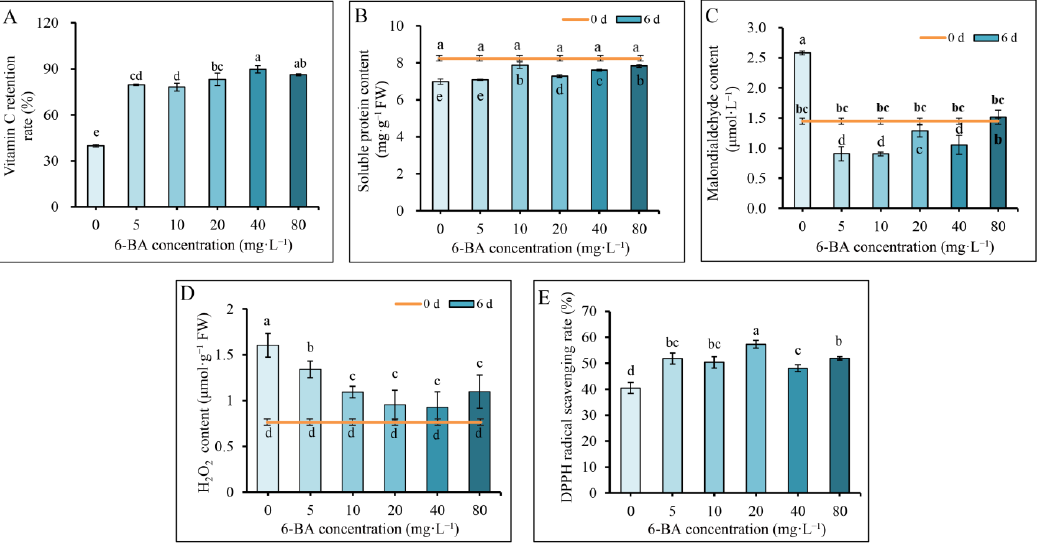
Figure 3. Postharvest 6-BA treatment maintains nutritional quality and antioxidant capacity of Chi- nese flowering cabbage during storage. Effect of postharvest 6-BA treatments on Vc retention rate ( A ), soluble protein content ( B ), malondialdehyde (MDA) content ( C ), H 2 O 2 content ( D ), and DPPH radical scavenging rate ( E ) of Chinese flowering cabbage. Each bar indicates the mean ± standard deviation of three biological replicates, and different lowercase letters indicate significant differ- ences between Chinese flowering cabbage under different treatments ( p < 0.05).